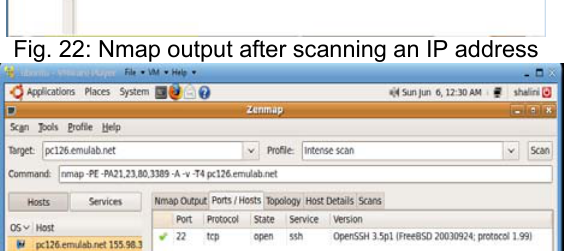
Fig. 22: Nmap output after scanning an IP address